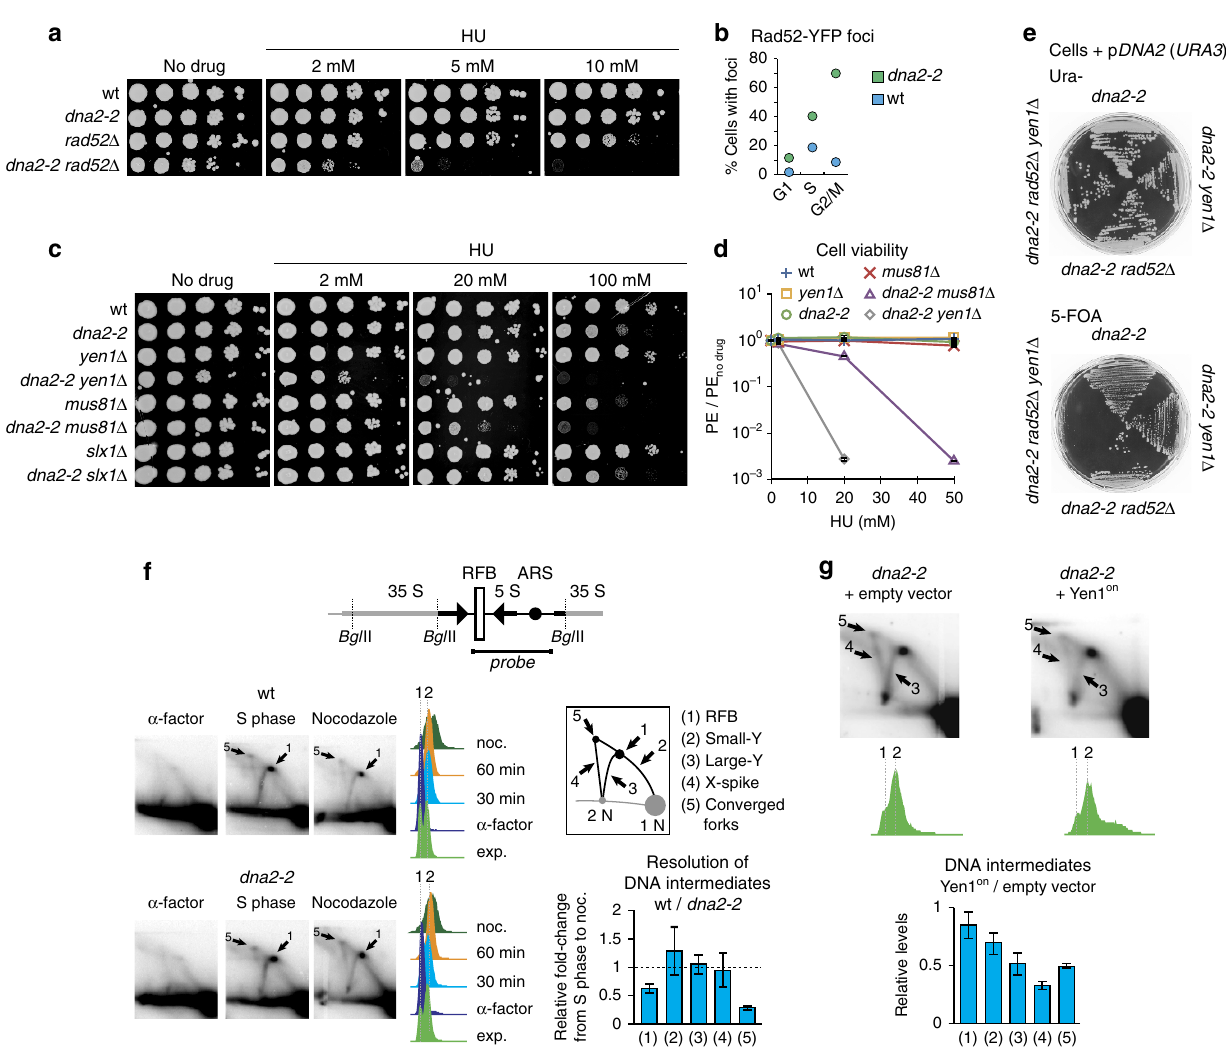
Figure 6 | Yen1 uniquely resolves toxic DNA intermediates in Dna2 helicase-defective cells along a pathway distinct from canonical HJ resolution. ( a ) Synergistic defects in the resistance to replication stress in homologous recombination-deficient dna2-2 rad52 D cells. Drop assay performed as in Fig. 3a. ( b ) Spontaneous Rad52-YFP foci in wild-type and dna2-2 cells in different cell cycle stages, determined by microscopic analysis ( Z 180 cells scored per strain). ( c ) Genetic interactions of dna2-2 with HJ resolvases YEN1 , MUS81-MMS4 and SLX1-SLX4 . Drop assays performed as in Fig. 3a. ( d ) Mean plating efficiency (PE) ± s.e.m. ( n ¼ 3) of the indicated strains assessed by colony outgrowth in the presence of increasing amounts of HU, relative to no- drug conditions. ( e ) Interaction between dna2-2 , RAD52 and YEN1 . Cells of the indicated genotypes and containing a plasmid expressing wild-type DNA2 (p DNA2 ) were grown under uracil selection to ensure retention of the p DNA2 , or on medium containing 5-FOA to select against the plasmid. Failure to grow on 5-FOA is indicative of an inviable genotype. ( f ) Analysis of replication and recombination intermediates in the rDNA of wild-type and dna2-2 cells traversing S phase into nocodazole-induced G2/M arrest. Genomic DNA was digested with Bgl II and subjected to 2D gel electrophoresis. The fragment probed by Southern hybridization contained the rDNA autonomously replicating sequence (ARS), the 5S transcriptional unit, and the RFB in its centre, as indicated. DNA structures chosen for quantification included RFB-arrested forks (1), Y-arc structures containing a replication fork at varying positions outside the RFB (2,3), the X-spike indicative of four-way branched DNAs containing Holliday junctions or hemicatenanes (4), and forks converging at the RFB (5). Representative autoradiographies are marked for RFB-stalled (1) and converged replication fork intermediates (5), which were resolved less efficiently in dna2-2 cells compared to wild-type following S phase. Three independent experiments were quantified and the data are presented as mean values ± s.e.m. ( g ) 2 D analysis as in f , but using exponentially growing dna2-2 cells expressing or not Yen1 on . Intermediates that were reduced upon Yen1 on expression are indicated. Three independent experiments were quantified and the data are presented as mean values ± s.e.m.